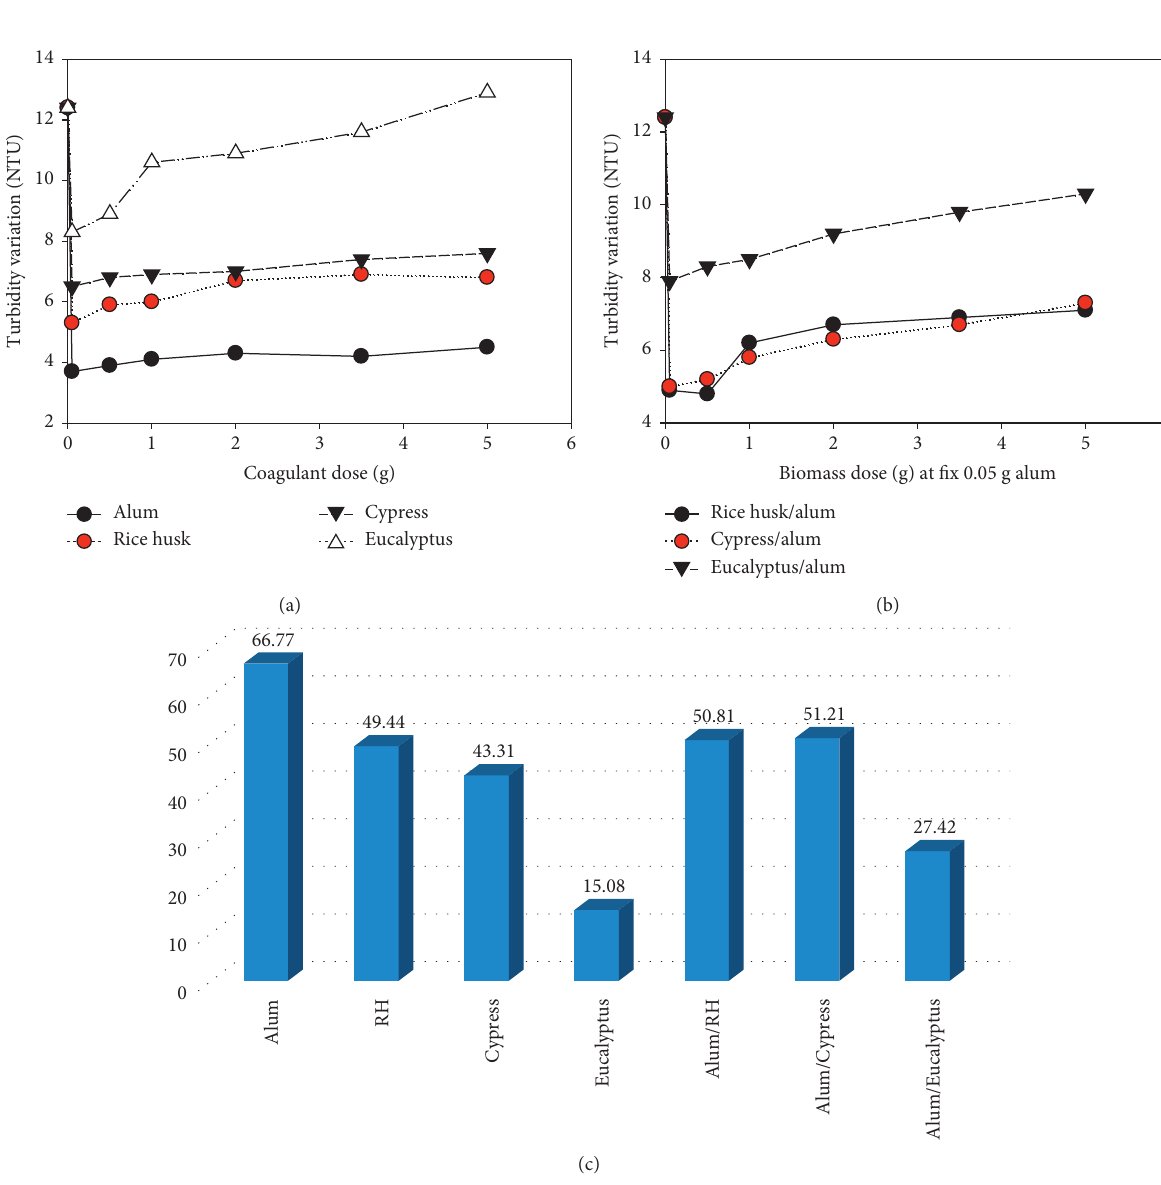
Figure 7: BSW variation of turbidity with (a) individual coagulants, (b) mixed coagulants, and (c) coagulation activities